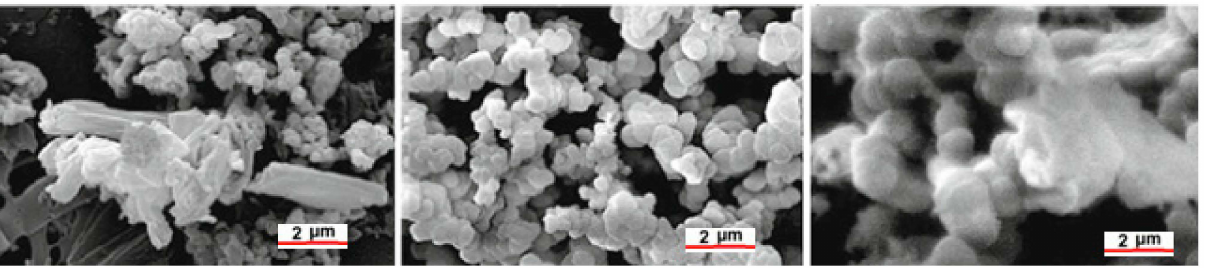
Figure 17. SEM micrographs of apatite layer formation at 20,000 magnification (reference bars 2 µ m) on the top surface of geopolymers (Ca/k: 3.82) soaked in SBF for 14, 28, and 90 days [128].